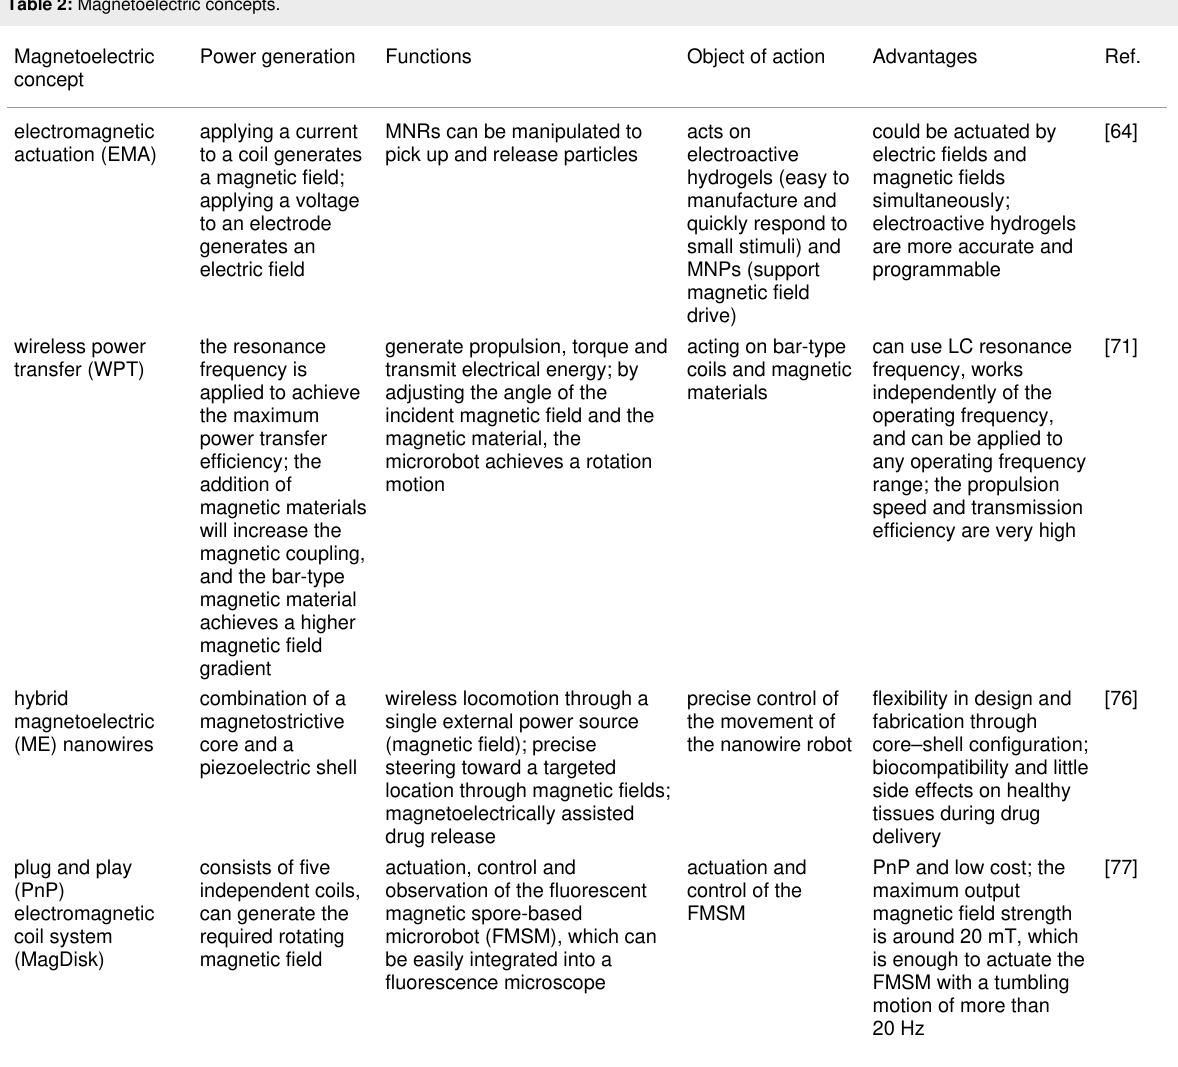
Table 2: Magnetoelectric concepts. Magnetoelectric